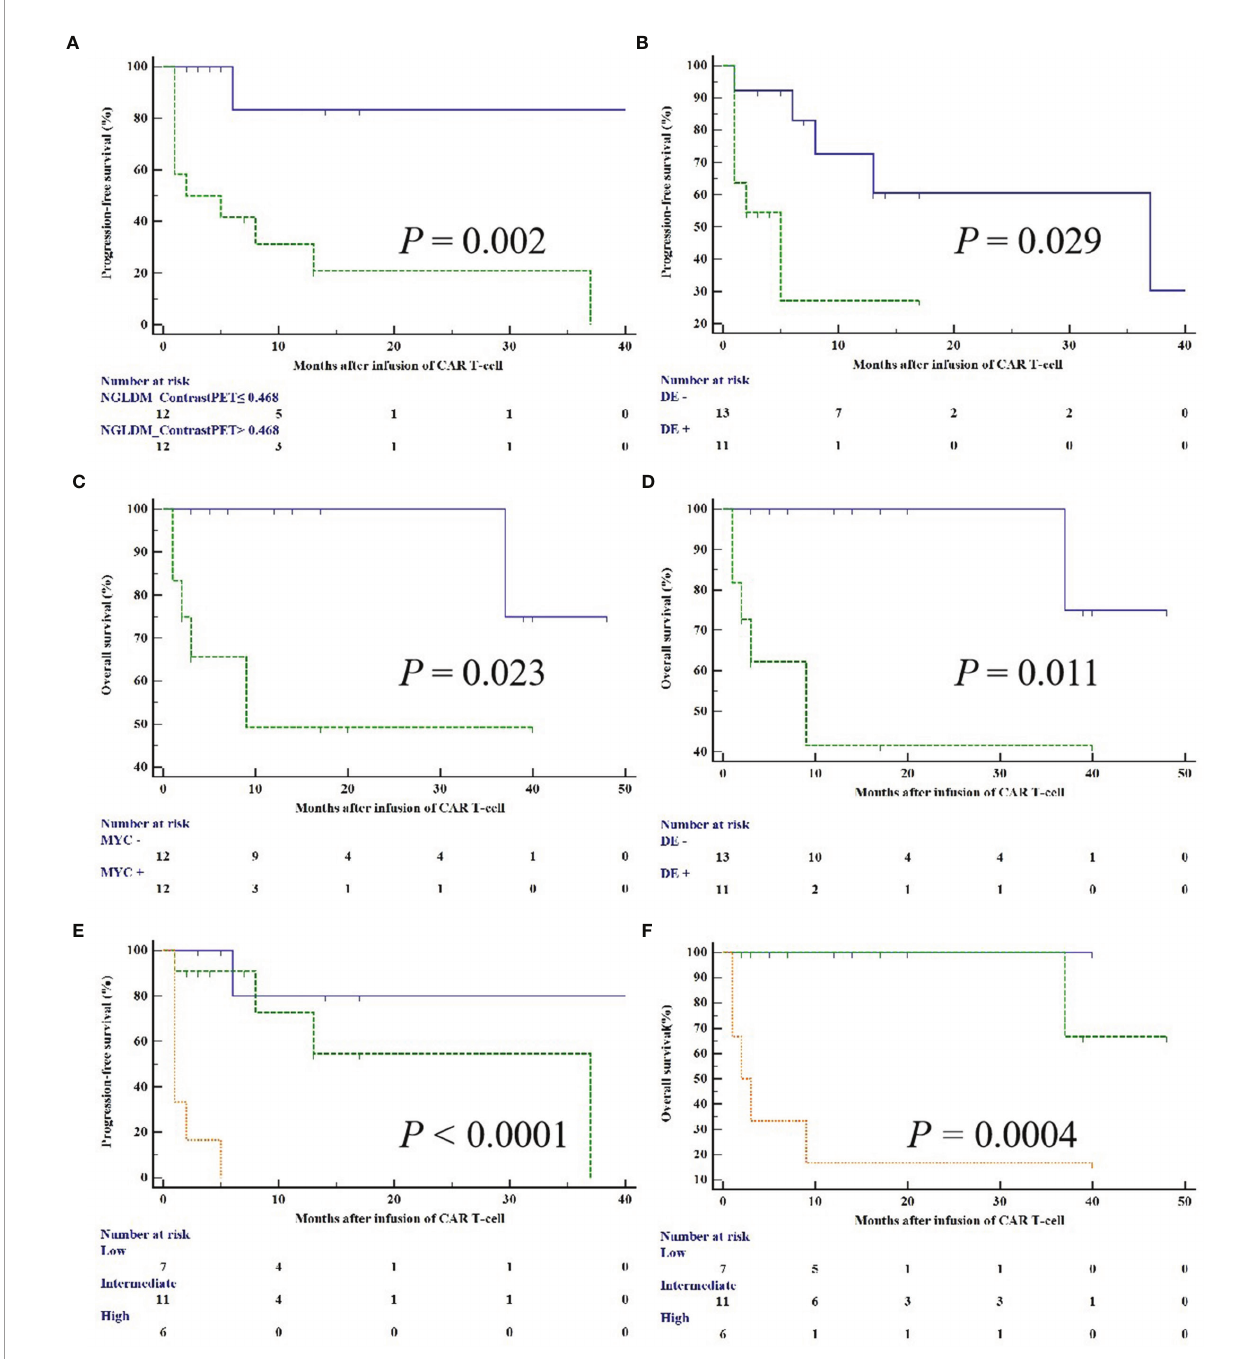
FIGURE 5 | Kaplan – Meier curves for PFS and OS according to NGLDM_Contrast PET (A) , MYC and BCL2 DE (B, D) , MYC (C) , and PET/CT scoring system (E, F)